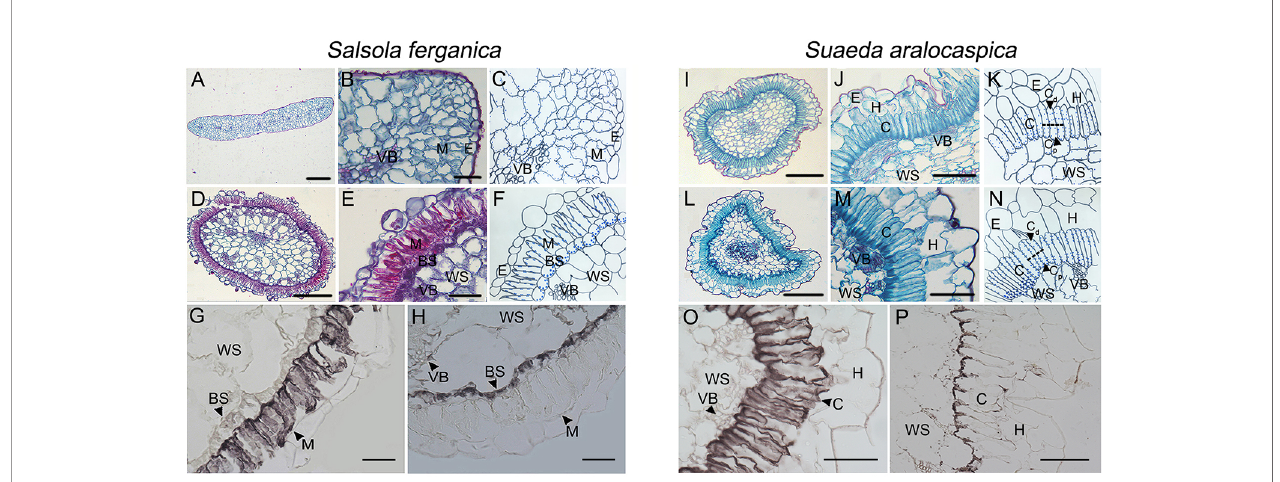
FIGURE 1 | Anatomic structures of cotyledon and leaf and immunohistochemical localization of PEPC and RUBPC of leaf in S. ferganica and S. aralocaspica . (A – H) S. ferganica ; (I – P) S. aralocaspica ; (A, D, I, L) Images of whole leaf cross section; (B, E, J, M) Enlarged images of part leaf cross section; (A, B, I, J) Cotyledon; (D, E, L, M) Leaf; (C, F, K, N) The schematic drawing corresponding to B, E, J, M; (G, O) PEPC; (H, P) RUBPC. BS, bundle sheath; C, chlorenchyma; M, mesophyll; VB, vascular bundle; WS, water storage. The images of anatomic structure and immunohistochemical localization of PEPC and RUBPC were all acquired from mature leaves of outdoor plant. Scale bar in A, D, I, L is 200 m m; B, E, G, H, J, M, O, P is 50 m